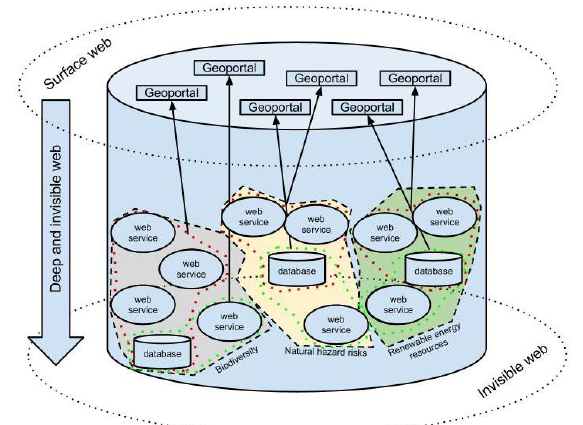
Figure 2 Geospatial-Web components and their positions in the web (Florczyk,